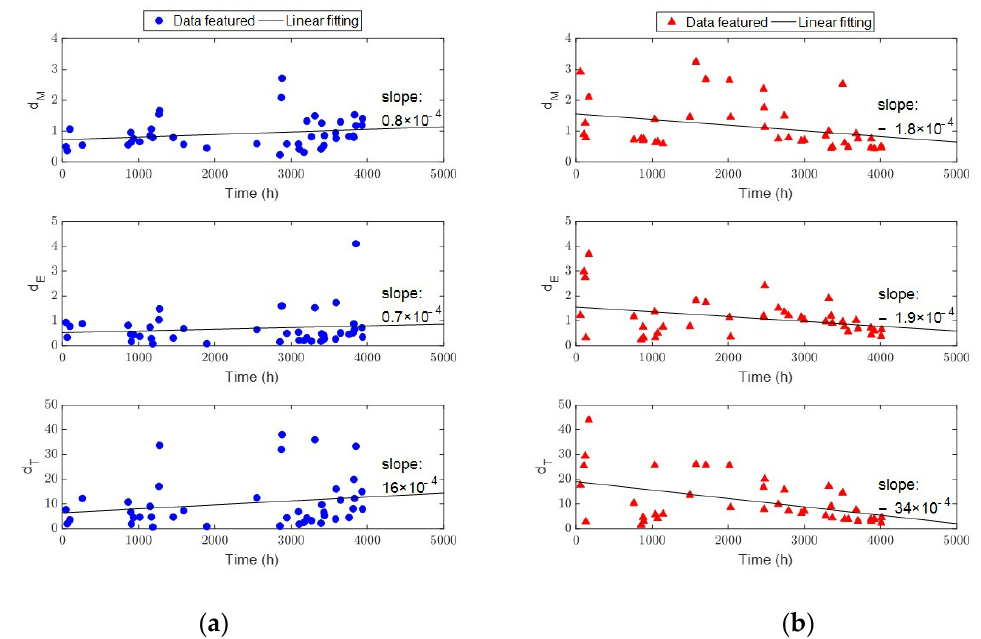
Figure 11. Degradation feature with correction factor using Equations (2)–(4): ( a ) barrier screw; ( b ) Maddock screw.